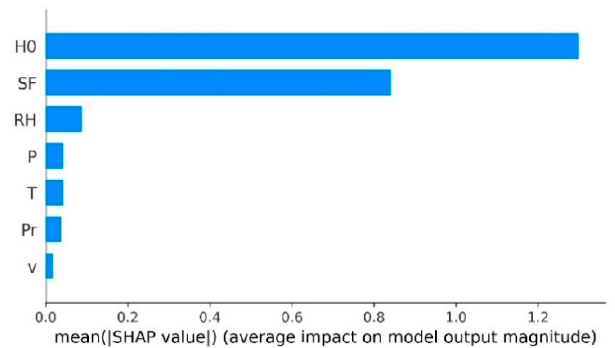
Figure 8. SHAP feature importance plot.